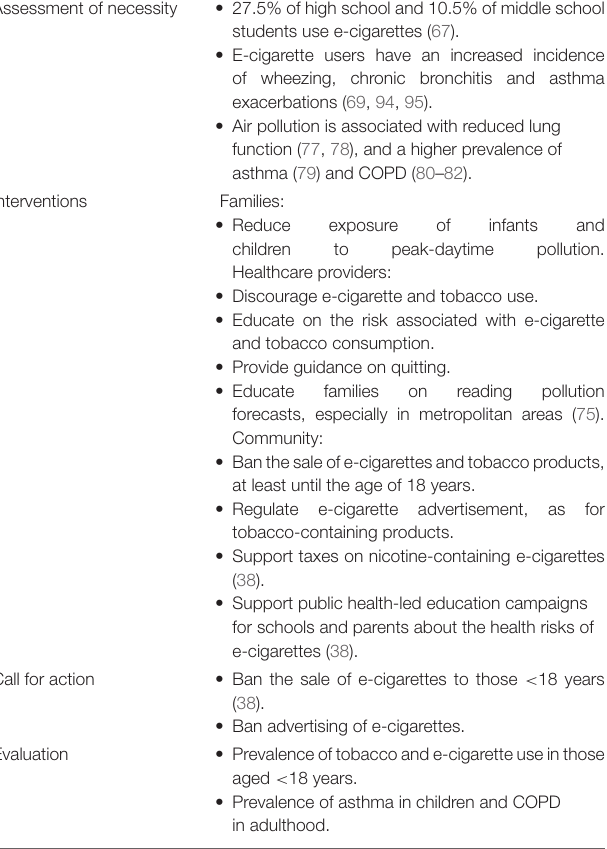
TABLE 3 | Respiratory health. Assessment of necessity